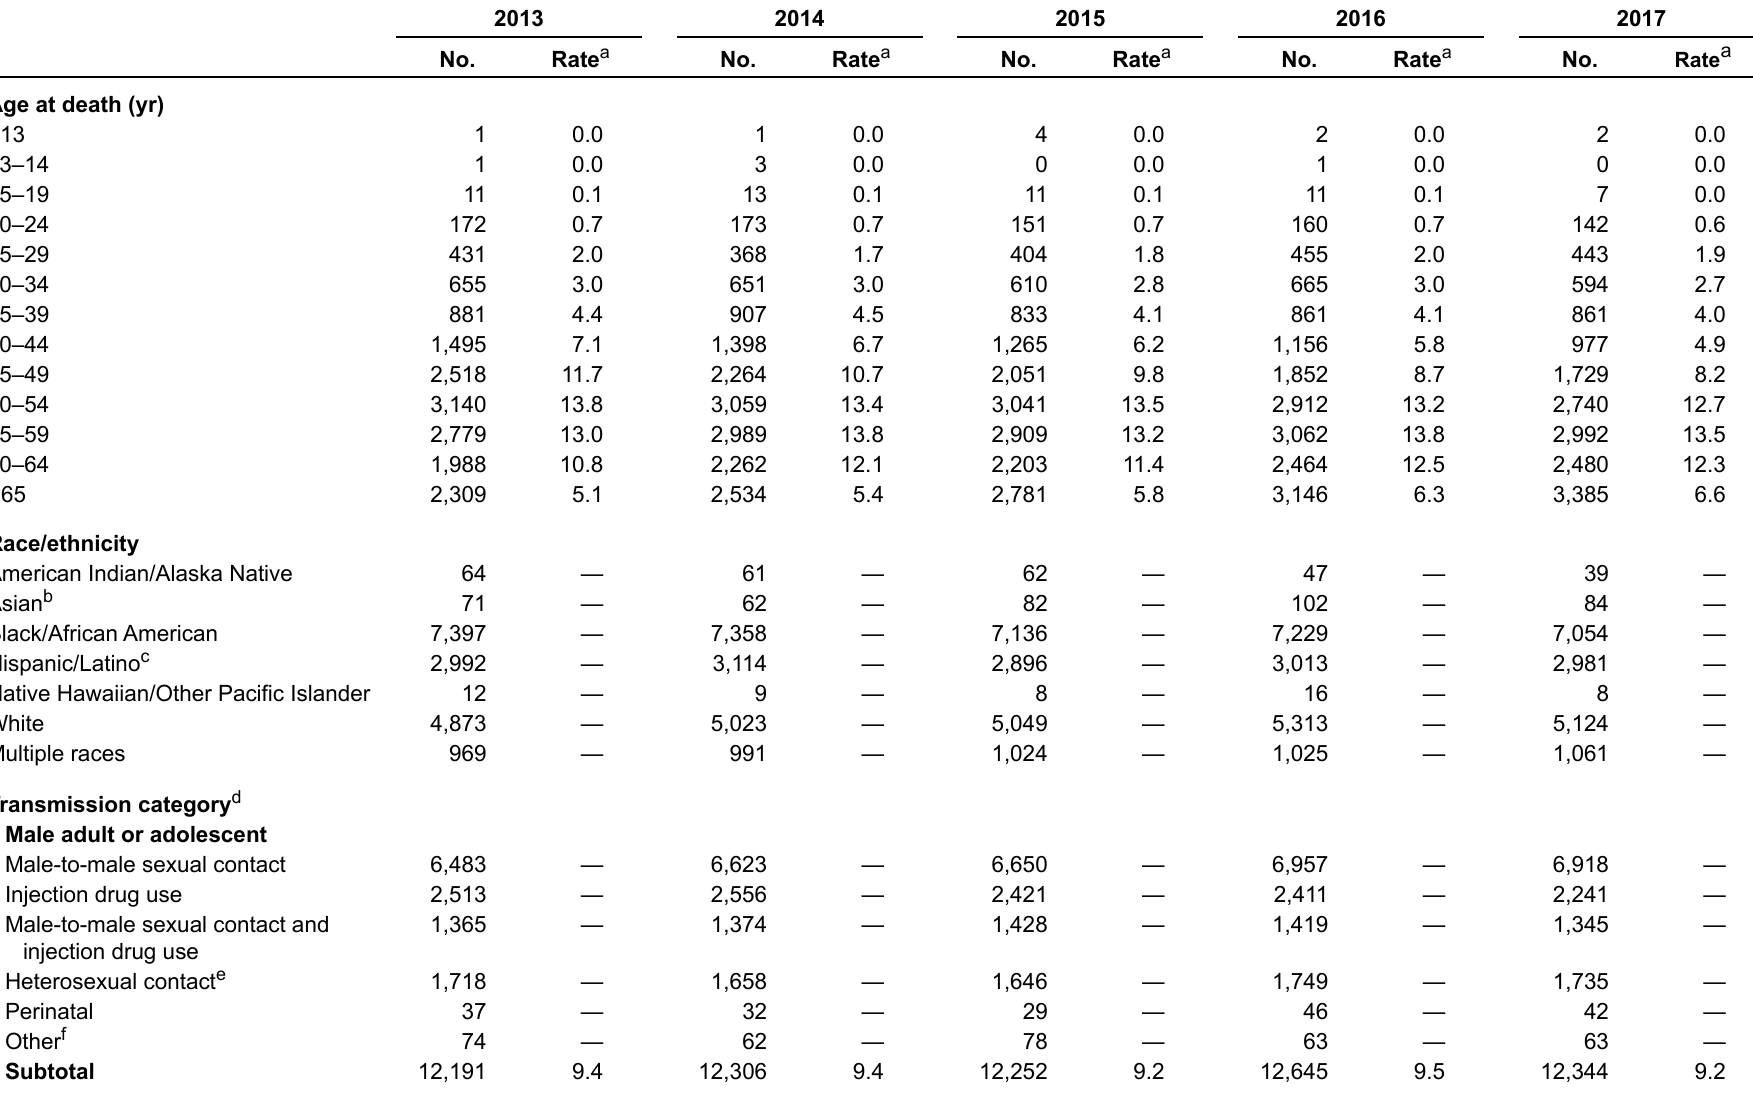
Table 18b. Deaths of persons with diagnosed HIV infection, by year of death and selected characteristics, 2013–2017—United States